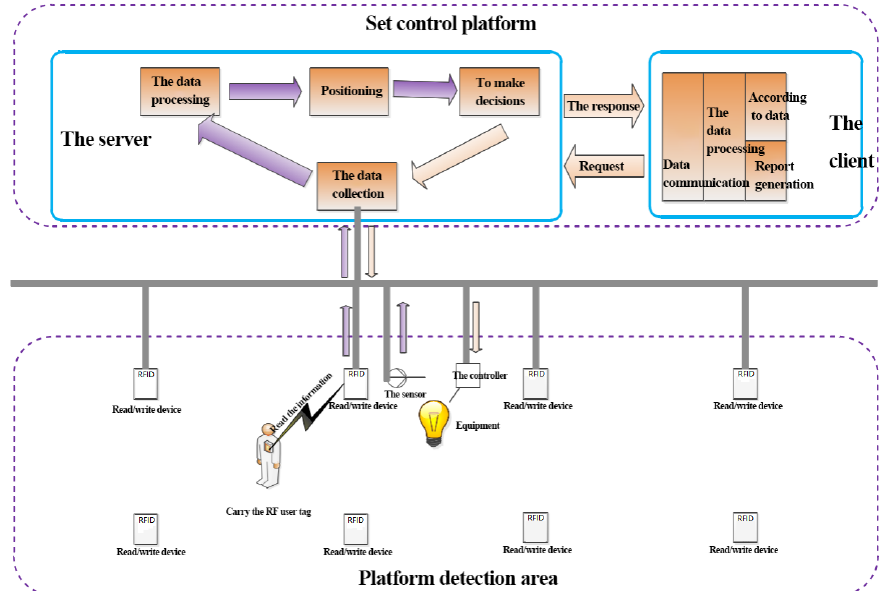
Figure 6. Personalized control principle.